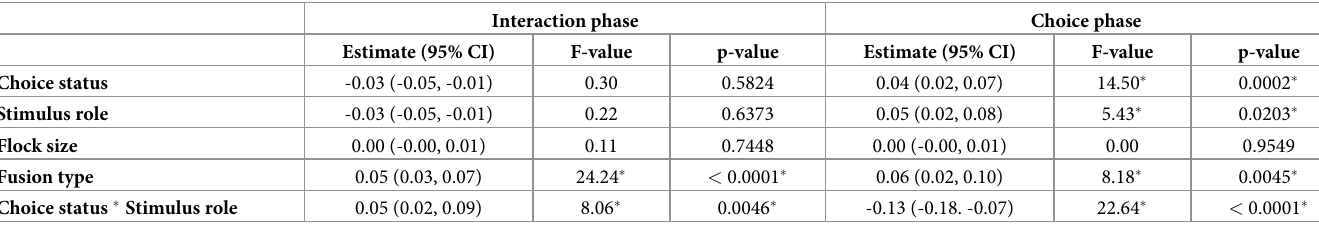
Table 3. Stimulus-response similarity results for male